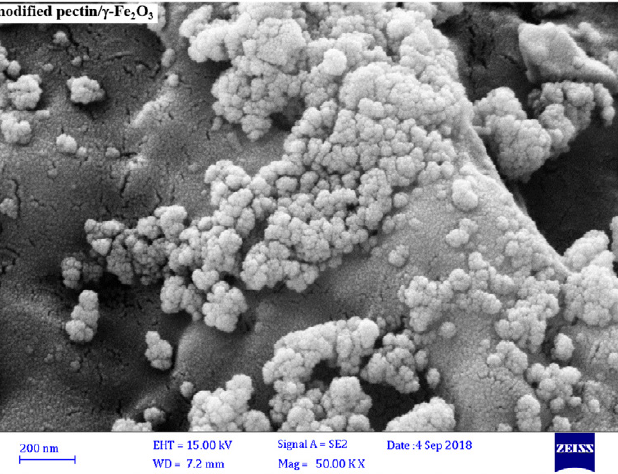
Figure 3 a. The FESEM images of maghemite nanoparticles, pectin/ γ -Fe